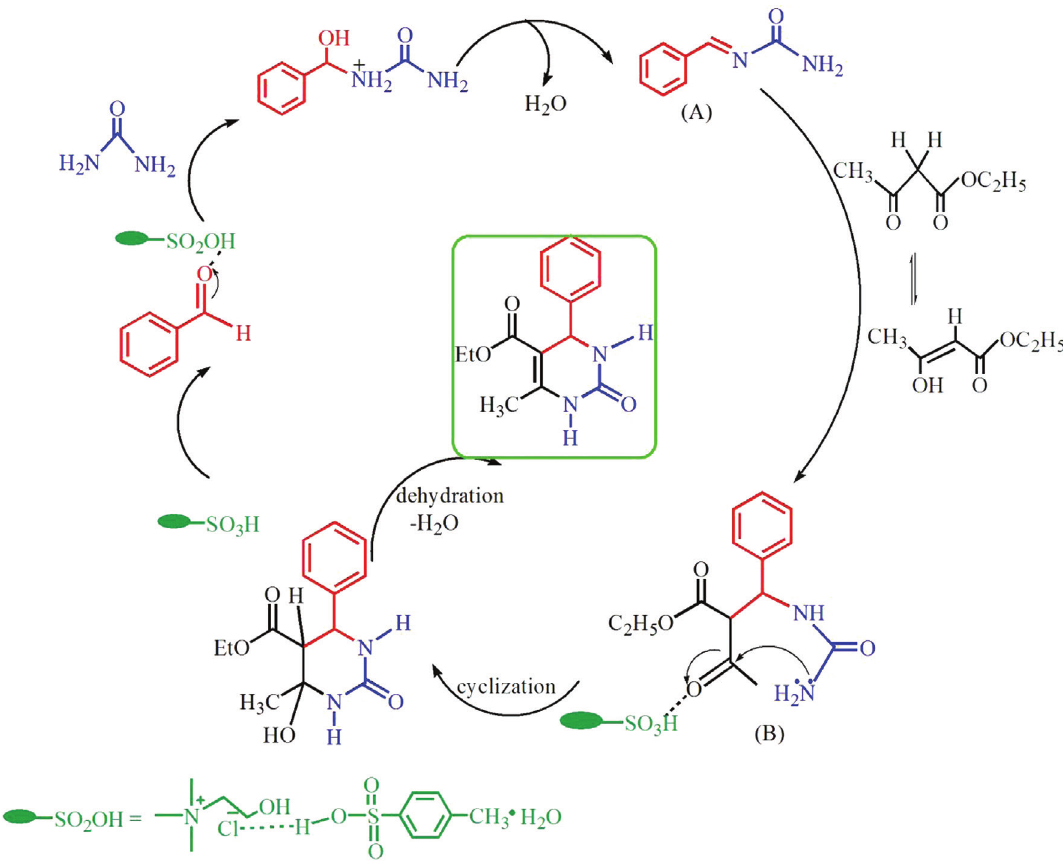
Figure 3: Mechanism of Biginelli reaction in the presence of ChCl/2PTSA.